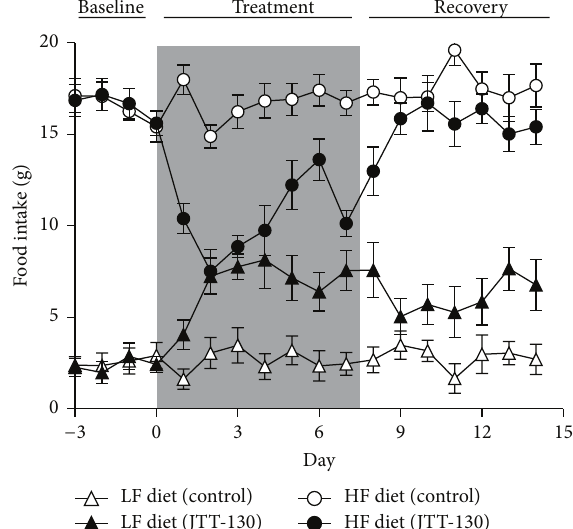
Figure 2: Effect of JTT-130 on LF and HF diet selection during the study period. Rats were allowed to have free access to LF and HF diet. JTT-130 was administered orally to rats at a dosage of 10mg/kg for seven days. Data are presented as means ± S.E. from ten animals. Open circle: HF diet intake in the control group; closed circle: HF diet intake in the JTT-130 group; open triangle: LF diet intake in control group; closed triangle: LF diet intake in the JTT-130 group.